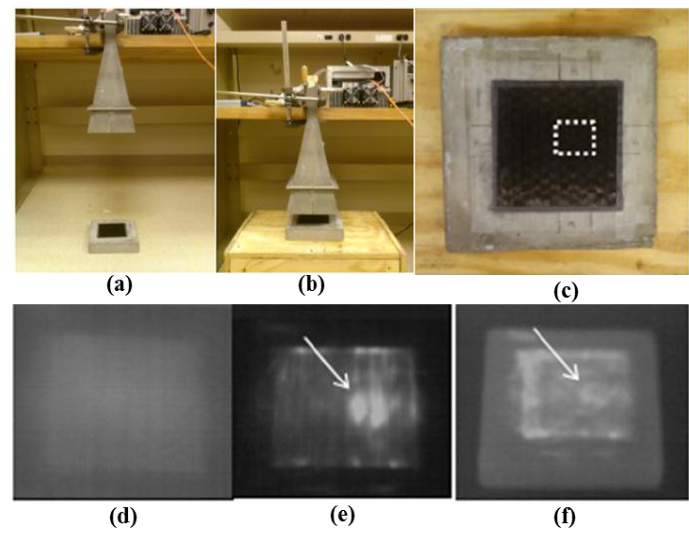
Figure 16. MWT measurement system setup used for 45 cm ( a ) and 6 cm ( b ) standoff, photograph of mortar sample with delamination ( c ). Measurements on mortar sample before heating ( d ), 6 cm standoff after 5 s heat ( e ) and 45 cm standoff after 15 s heat ( f ) [58]. Reprinted/reproduced with permission from IEEE.